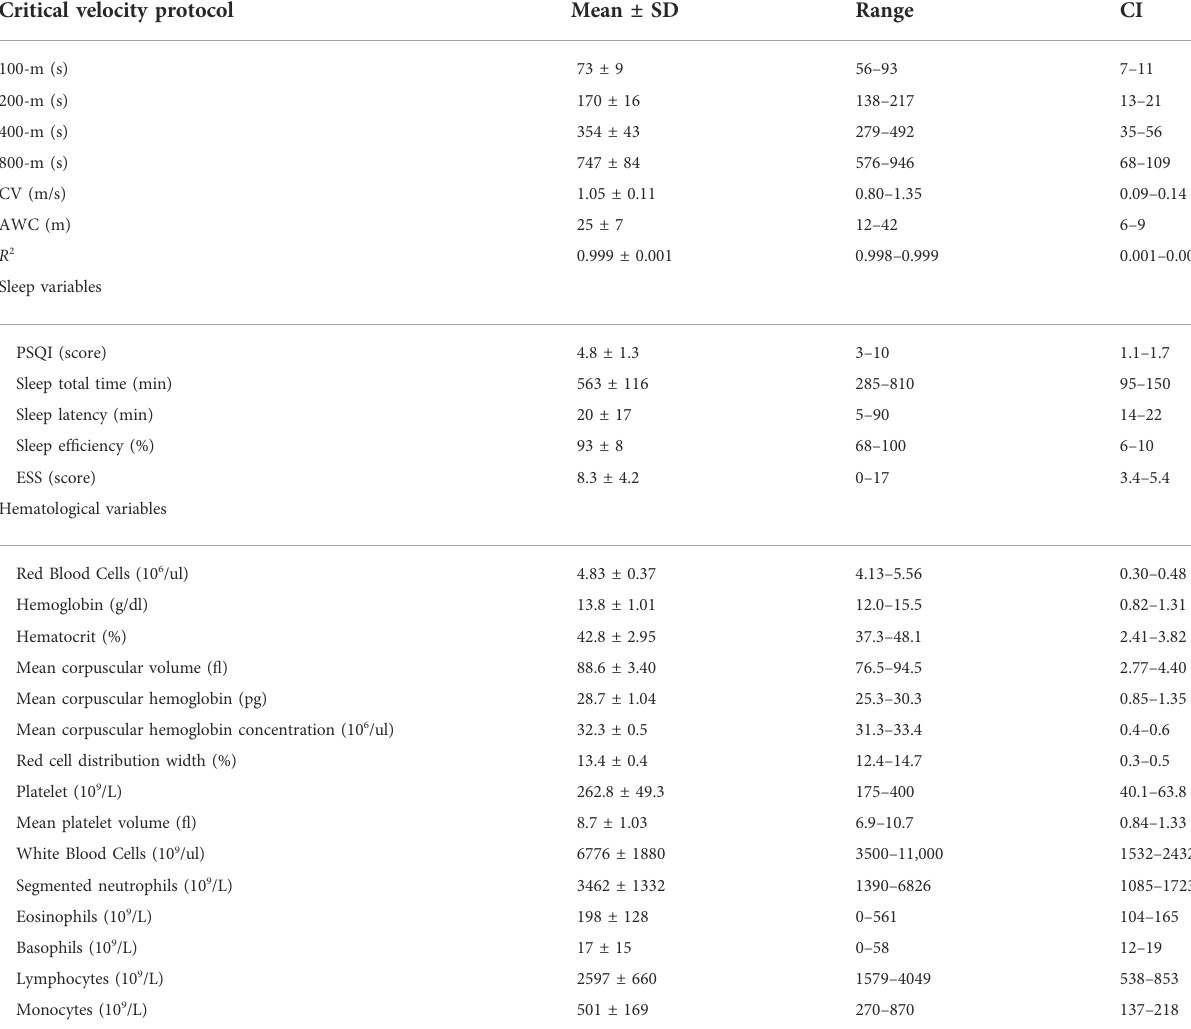
TABLE 1 Outcomes from the critical velocity protocols, sleep questionnaires, and hematological